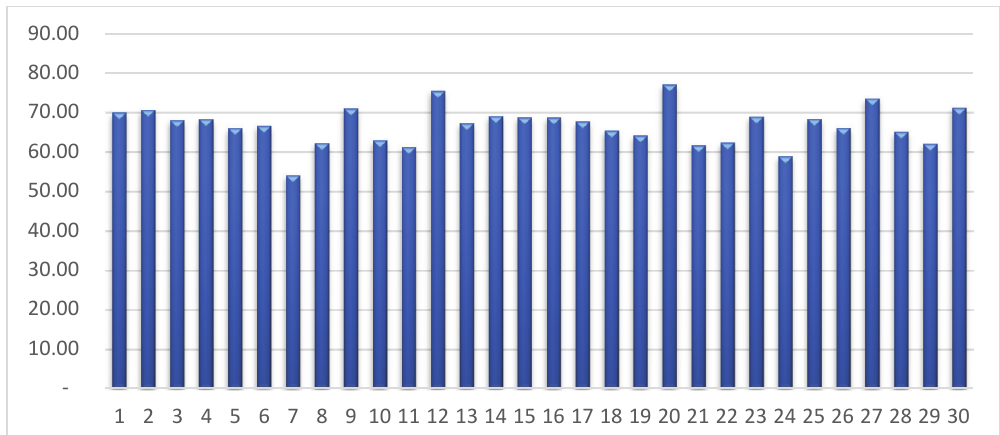
Fig. 3. The comparison of Disclosure Index of listed companies